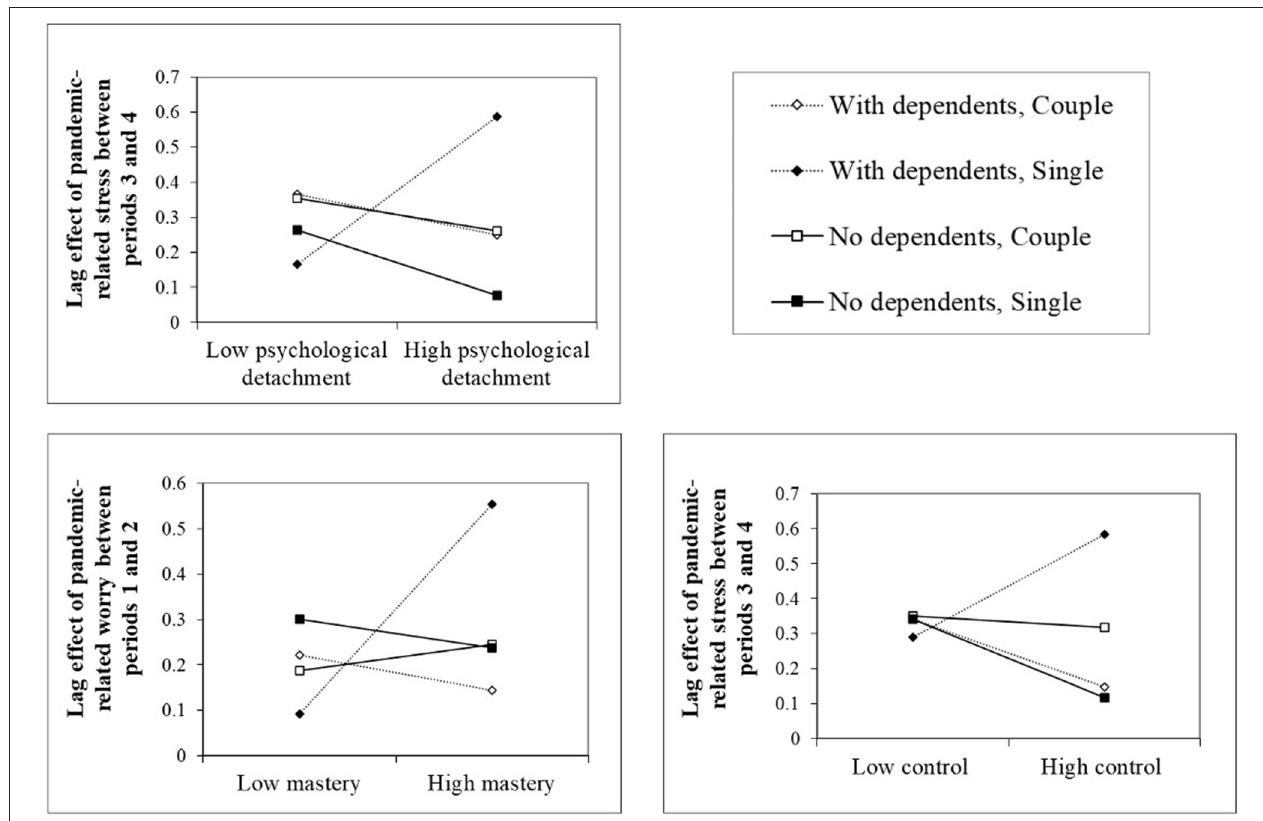
FIGURE 2 | The 4-ways interactions between recovery experiences, care for dependent, status and